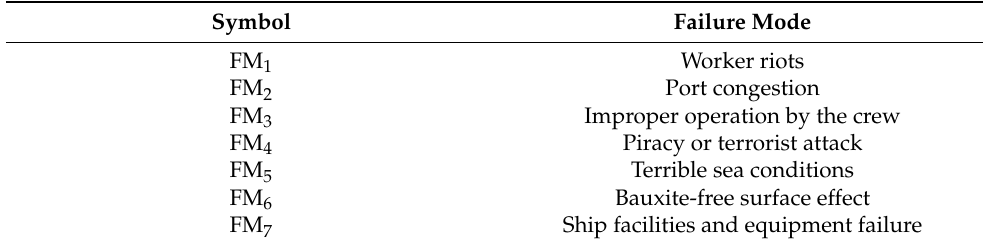
Table 8. List of failure modes of bauxite maritime